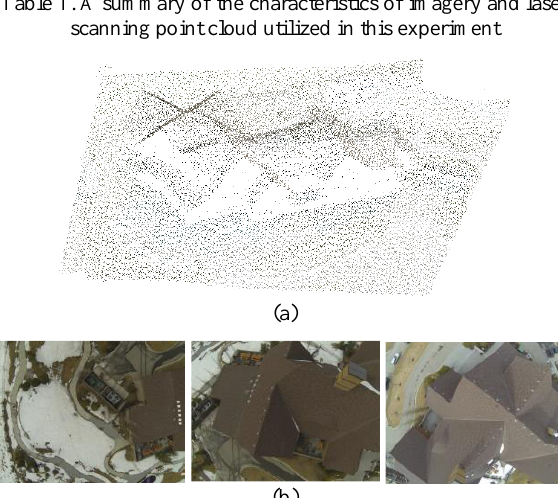
Figure 5. (a) Low-density laser scanning point cloud and (b)